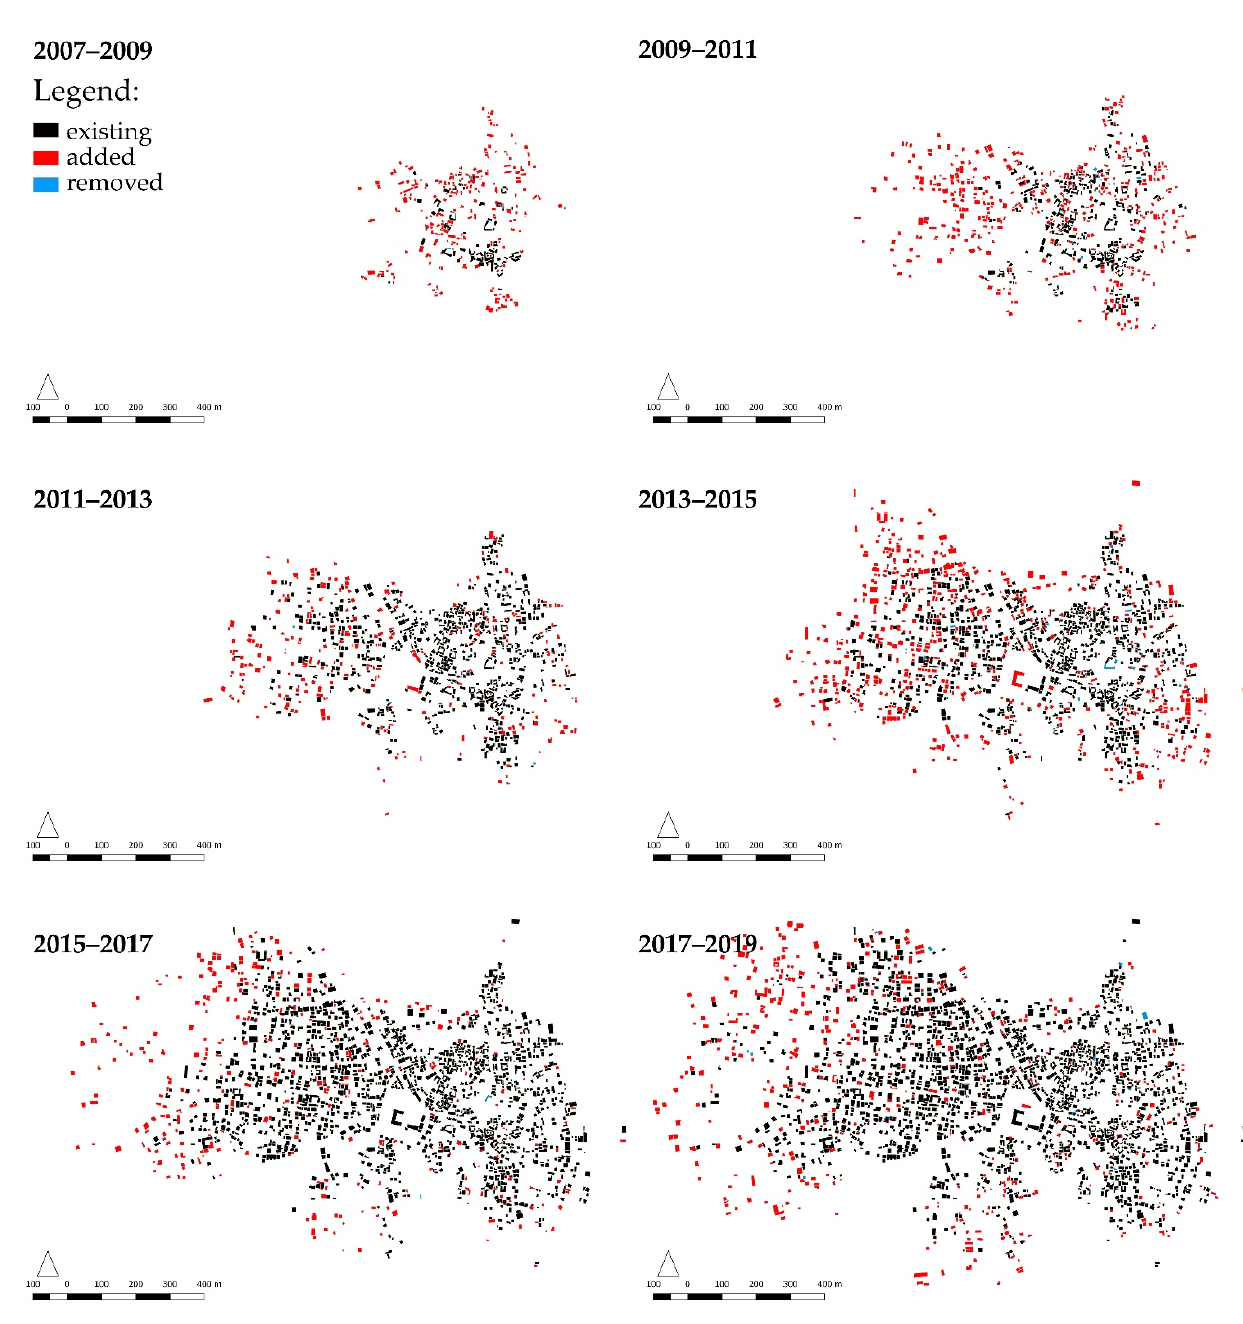
Figure 5. Mapping the emerging building footprints.